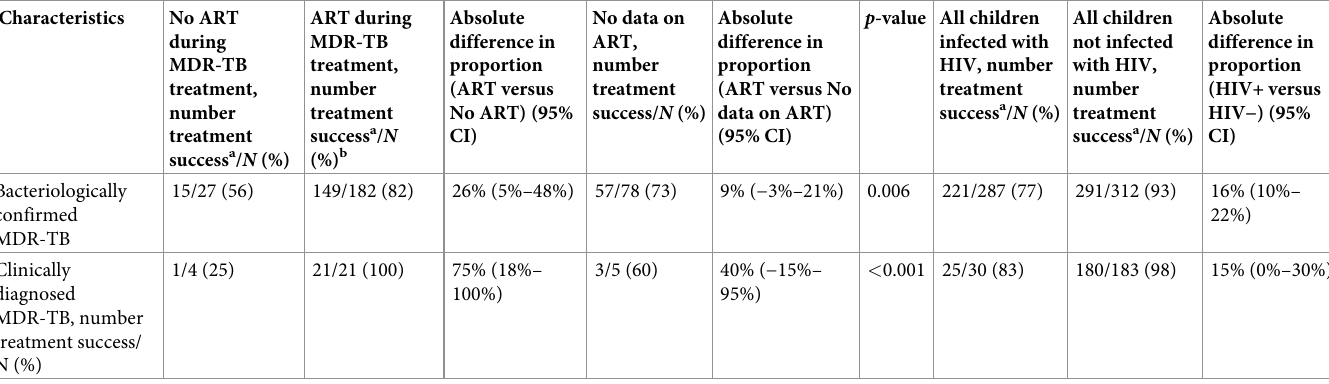
Table 4. Comparing treatment success rates among children with MDR-TB infected with HIV, by timing of initiation of ART and by HIV status a .